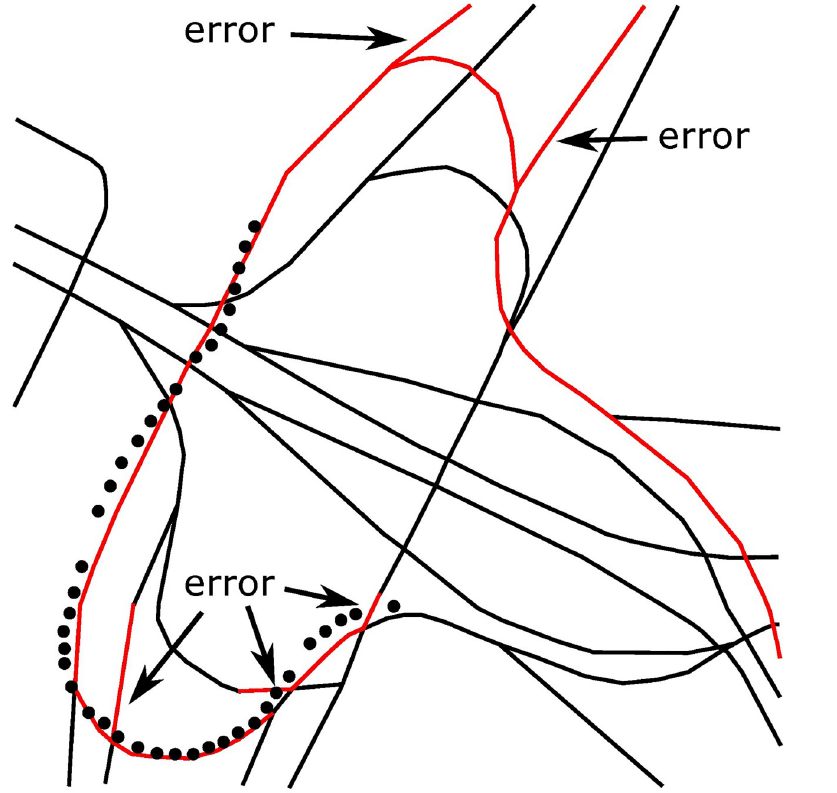
Fig 6. Part of the test chart of an overpass.